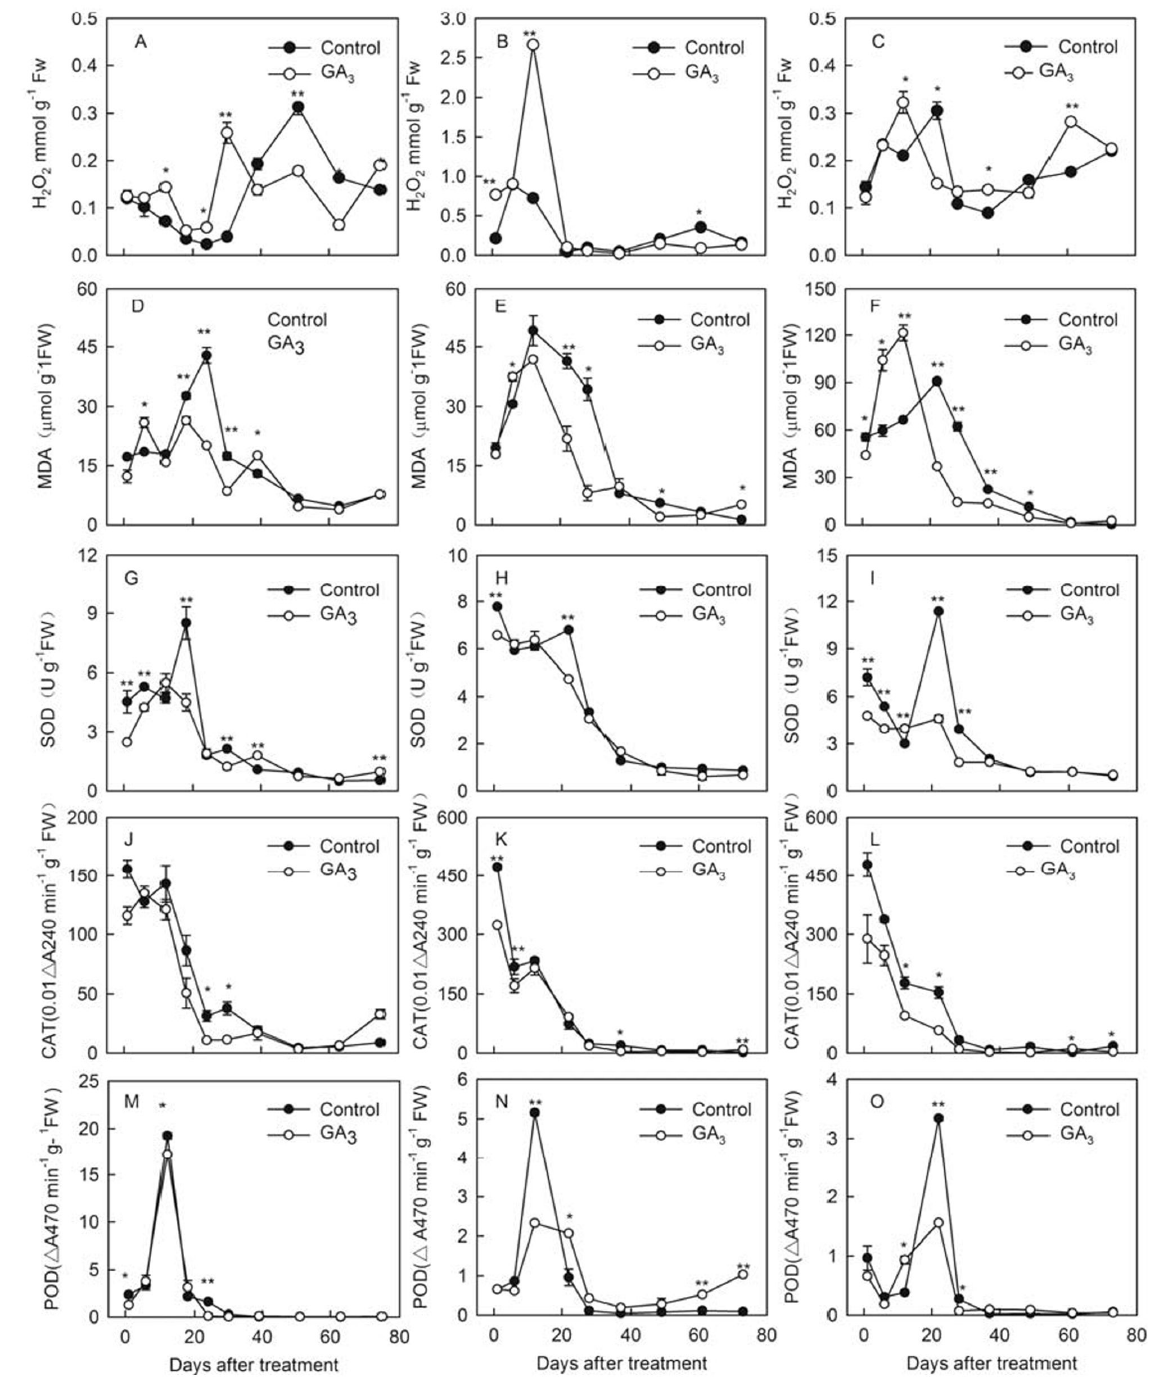
Figure 4. Changes in H O and MDA accumulation, as well as antioxidant enzyme activities, after GA 2 2 H O accumulation in ‘Kyoho’ (A), ‘Red Globe’ (B) and ‘Thompson Seedless’ (C) cultivars; (D-F) MDA accumulation in ‘Kyoho’ (D), 2 2 ‘Red Globe’ (E) and ‘Thompson Seedless’ (F) cultivars; (G-I) SOD activity in ‘Kyoho’ (G), ‘Red Globe’ (H) and ‘Thompson Seedless’ (I) cultivars; (J-K) CAT activity in ‘Kyoho’ (J); ‘Red Globe’ (K) and ‘Thompson Seedless’ (L) cultivars; (M-O) POD activity in ‘Kyoho’ (M), ‘Red Globe’ (N) and ‘Thompson Seedless’ (O) cultivars. Data points represent the mean ± SE of at least three replicates. Asterisks indicate significant differences between GA -treated and untreated control samples from the same cultivar (* P < 0.05, ** P 3 < 0.01, Student’s t –test). doi: 10.1371/journal.pone.0080044.g004 PLOS ONE |